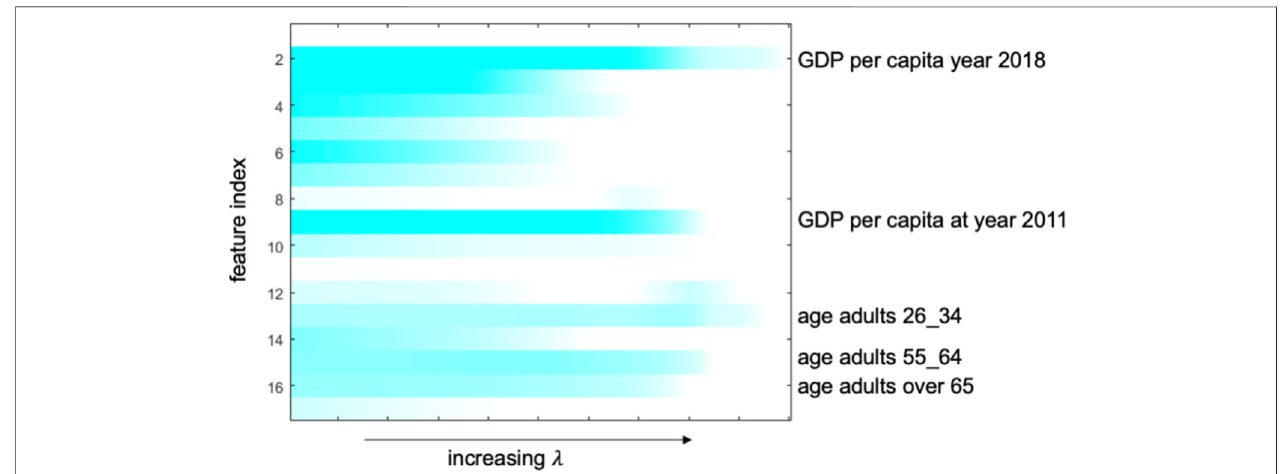
FIGURE 2 | The weightings of different indicators with increasing sparsity penalty λ